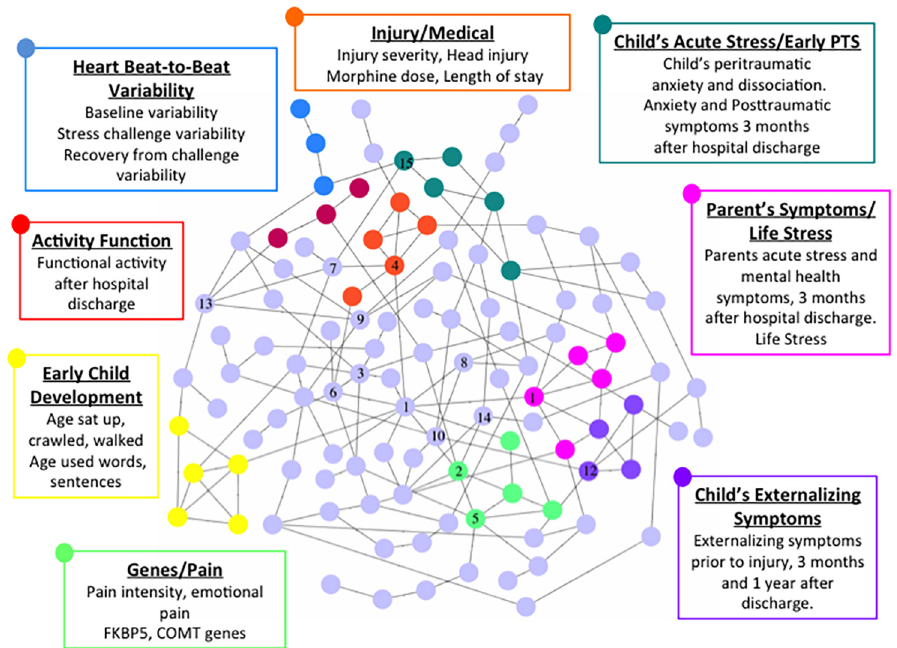
Fig 5. The CHIDS Network and its Eight Modules. The 15 highest ranked nodes based on BC score are indicated by numeric rank order.